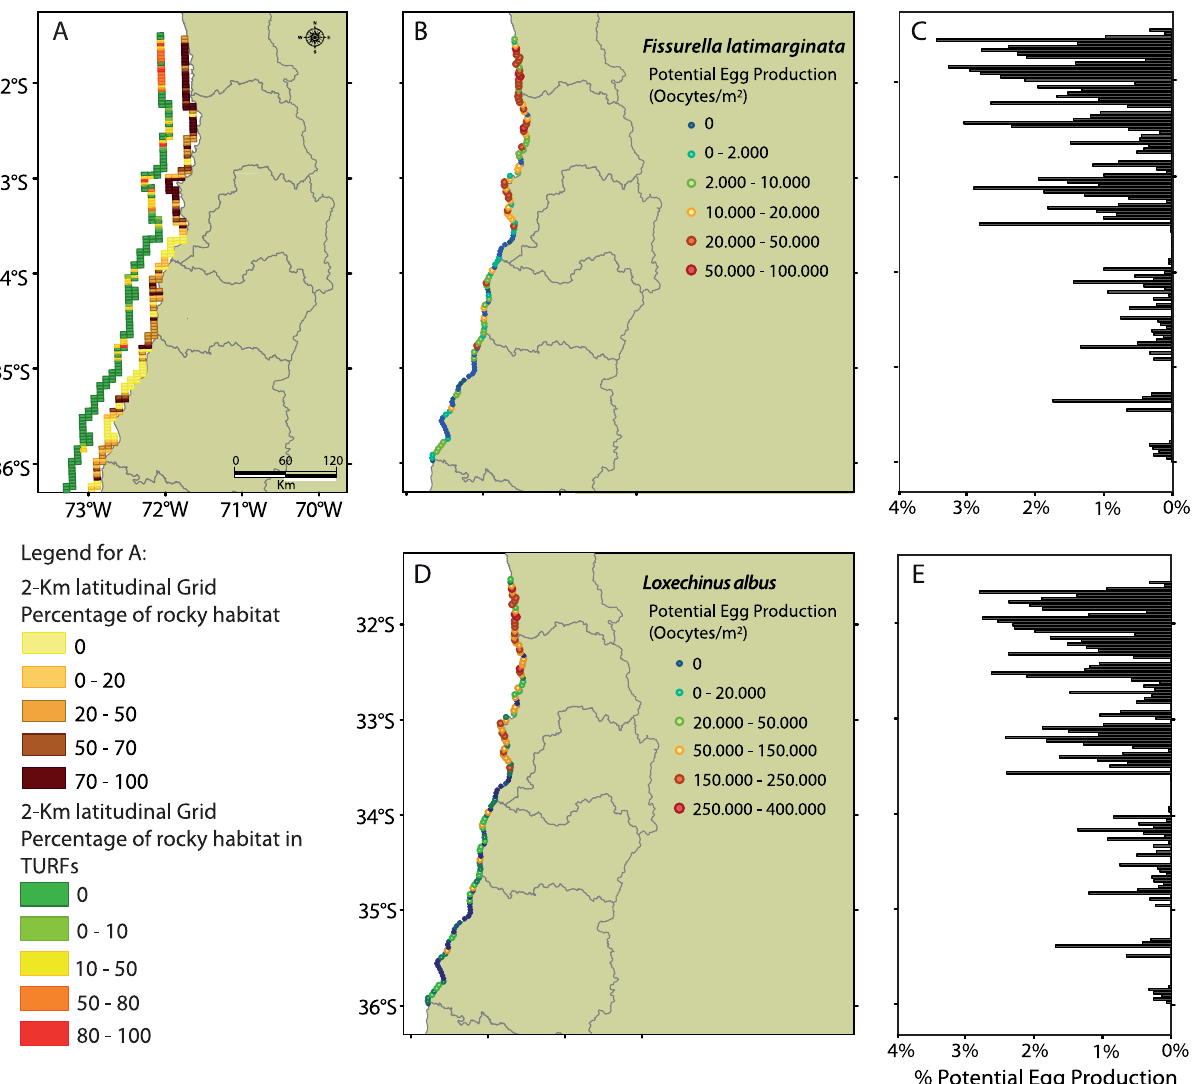
Fig 3. Spatial distribution of habitat, restrictedaccessareas and potential egg production. Spatial maps showing(A) percentageof coastlinewith rocky habitat and restricted access (Territorial Use Rights for Fisheries, TURFs) and (B, D) predictedpotentialegg production (oocytes/m 2 ) along a latitudinalgradientwith a 2-km grid resolution. Plots C and E show the contribution(percentage) of oocytes/m 2 (potentialegg production)of each grid to the regional(study area) production.